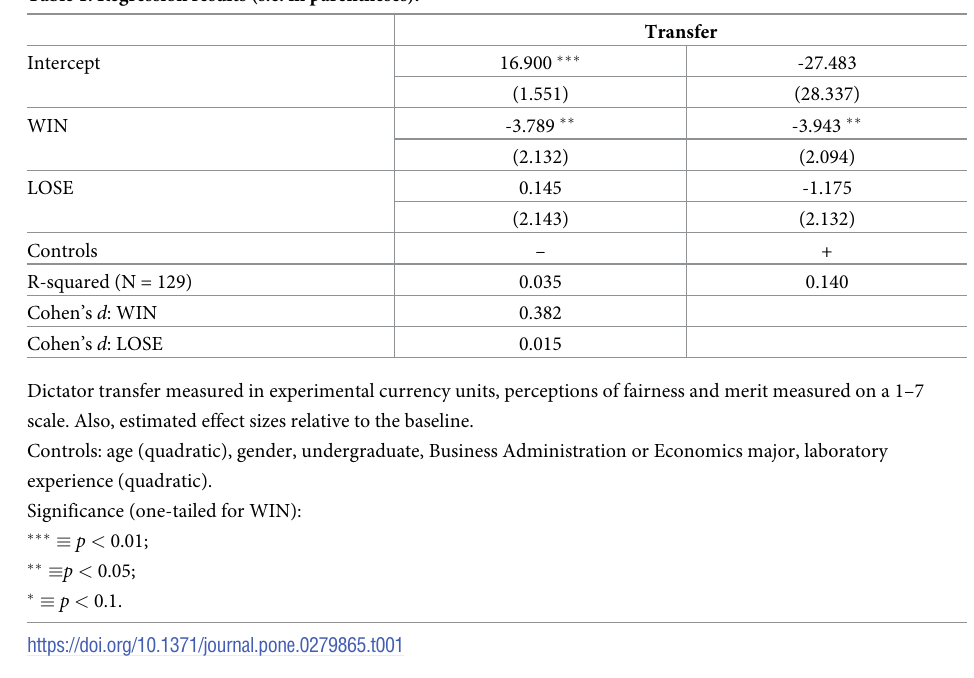
Table 1. Regression results (s.e. in